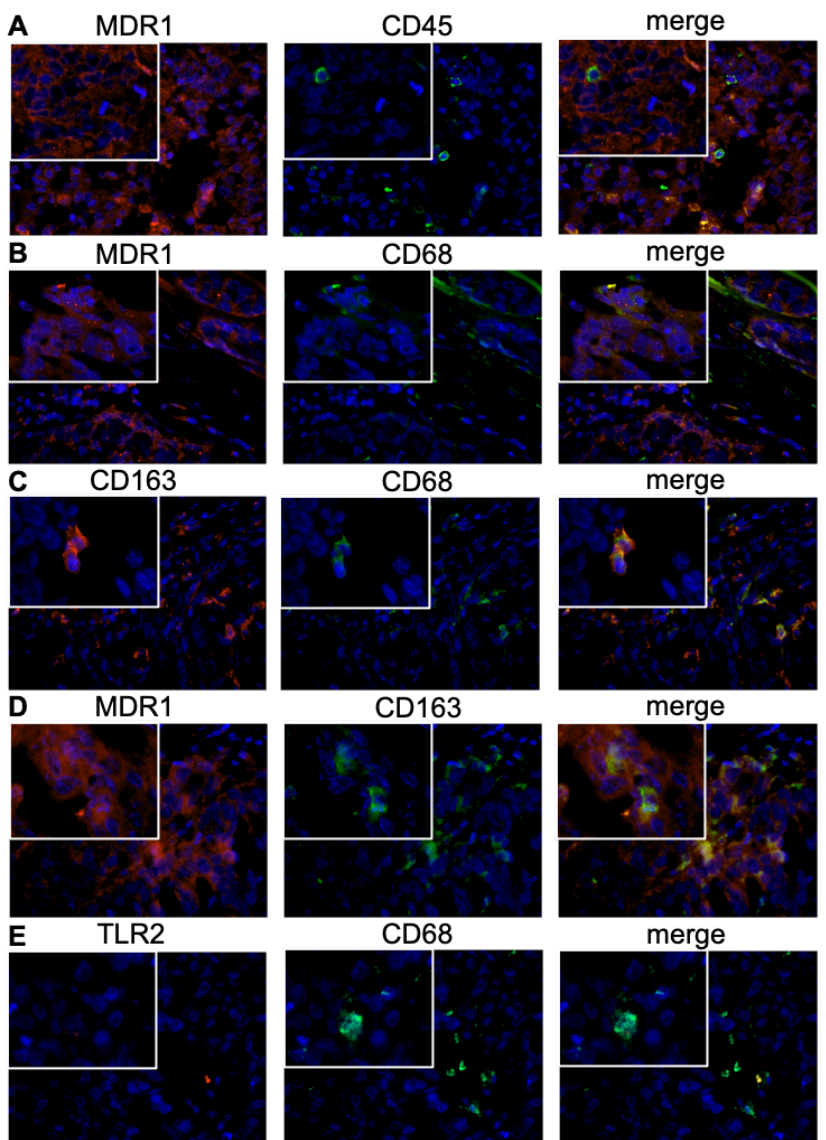
Figure 5. Characterization of the immune cell subpopulation by immunofluorescence double staining. M2 macrophages were identified as main part of the MDR1 + leucocyte infiltrate, expressing besides MDR1 the M2 marker CD163 ( D ) as well as the pan-macrophage marker CD68 ( B ). The stained tissue slices of serous ovarian cancer tissue were analyzed in 40 × and 63 × (inserts) magnification. For most CD45 positive immune cells (green) a co-localization with MDR1 (red) was observed ( A ); co-expression of MDR1 (red) and CD68 (green) ( B ); co-expression of CD163 (red) and CD68 (green) ( C ); co-expression of MDR1 (red) and CD163 (green) ( D ); no co-expression of TLR2 (red) and CD68 (green) was detected ( E ). Cell nuclei were marked by DAPI (blue)